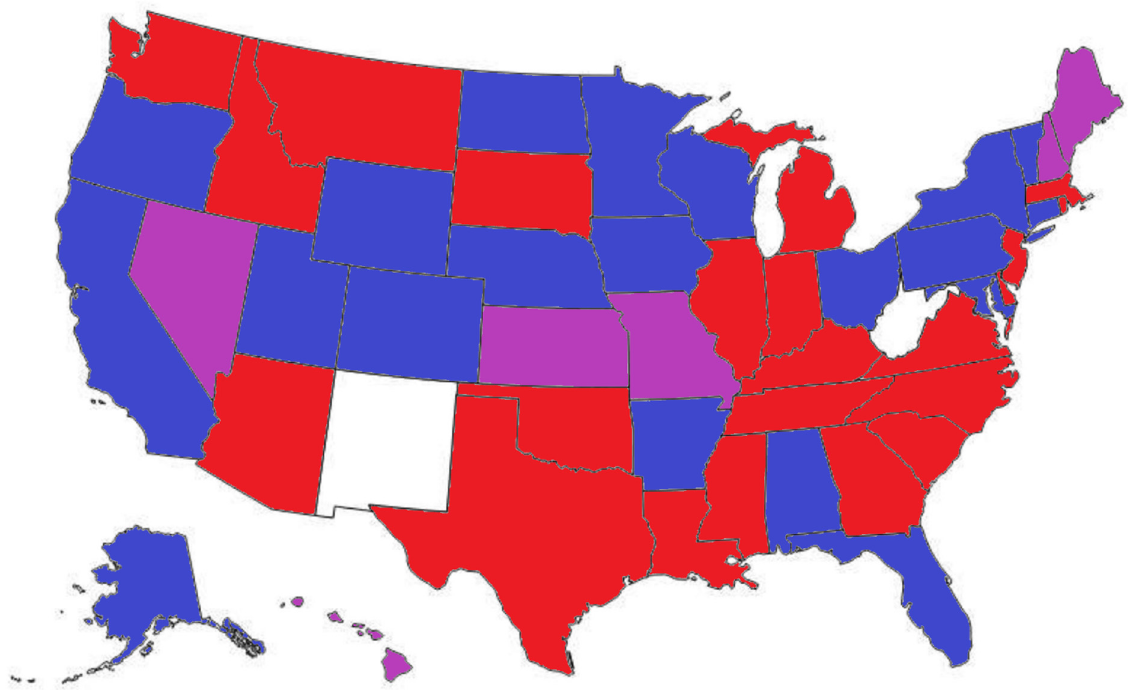
Figure 1. Jurisdictions that prohibit bestiality in the United States. States imposing a misdemeanor in blue, a misdemeanor with felony enhancements in purple, and a felony in red.